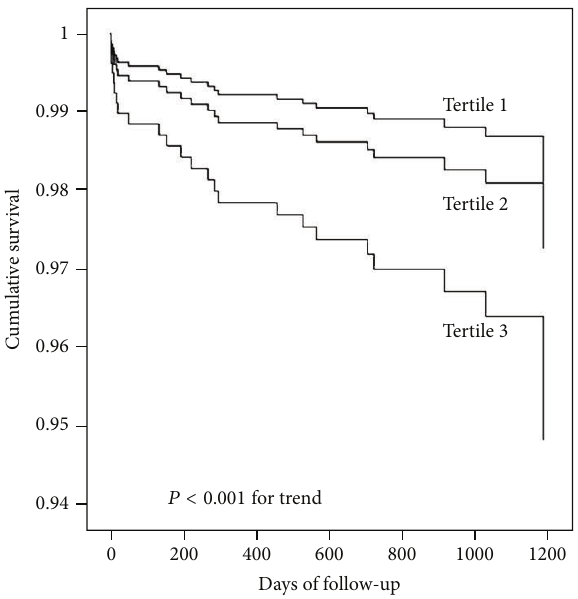
Figure 2: Kaplan-Meier hazard plots for cardiovascular disease mortality by tertiles of interleukin-6. The probability values repre- sent the trend across all three